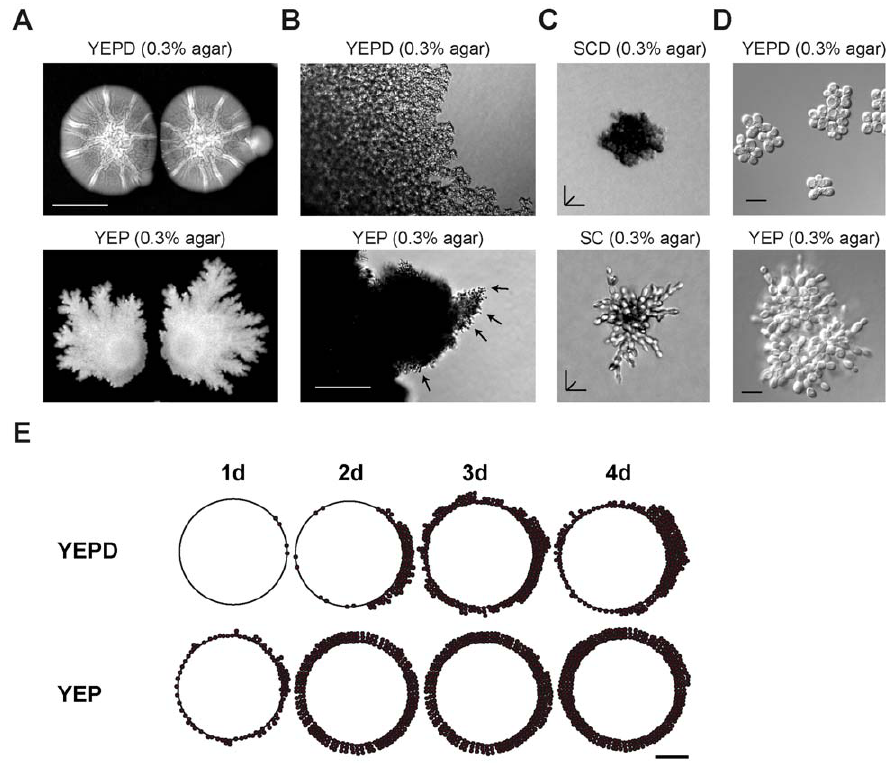
Figure 1. S.cerevisiae forms filamentous mats. A ) Wild-type cells (PC313) were spotted 2 cm apart onto 0.3% agar media that contained (YEPD; top panel) or lacked (YEP; bottom panel) glucose. The YEPD plate was incubated for 4 days and photographed; the YEP plate for 15 days. Bar=1 cm. B ) Microscopic examination of perimeters of mats in 1A. Bar=100 microns. C ) The origin of filamentous mats. Wild type (PC538) cells were examined on synthetic medium either containing 2% glucose (SCD) or lacking glucose (SC) in 0.3% agar medium for 24 h at 30 u C. A compiled Z-stack rendering of typical microcolonies are shown. Bar=20 microns. D ) Same strains in 1C were examined on rich medium either containing 2% glucose (YEPD) or lacking glucose (YEP) in 0.3% agar. A representative microscopic image is shown. Bar=10 microns. E) Vegetative mats mature into filamentous mats over time as nutrients become limiting. Two mats of wild type (PC313) strain were spotted bilaterally (1.5 cm apart) on YEPD and YEP media ( + 0.2% galactose) containing 0.3% agar media. The number of filaments occurring along the circumference of mats was scored on a scale of 1, 2, or 3 dots at 20 6 magnification corresponding to 3, 6, or 9 filaments or greater, respectively. Dots were plotted on a circle representing the outline of one of the mats with right hemispheres corresponding to the side of the mat facing a second mat. Asymmetric filamentation observed in the right hemisphere of 2d, Glu can possibly result from nutritional stress compounded by nutrient depletion from adjacent mats. Filamentation was monitored and plotted after growth for 1, 2, 3, and 4 days. Quantitation of pseudohyphae was complicated at longer time points when biofilms began to